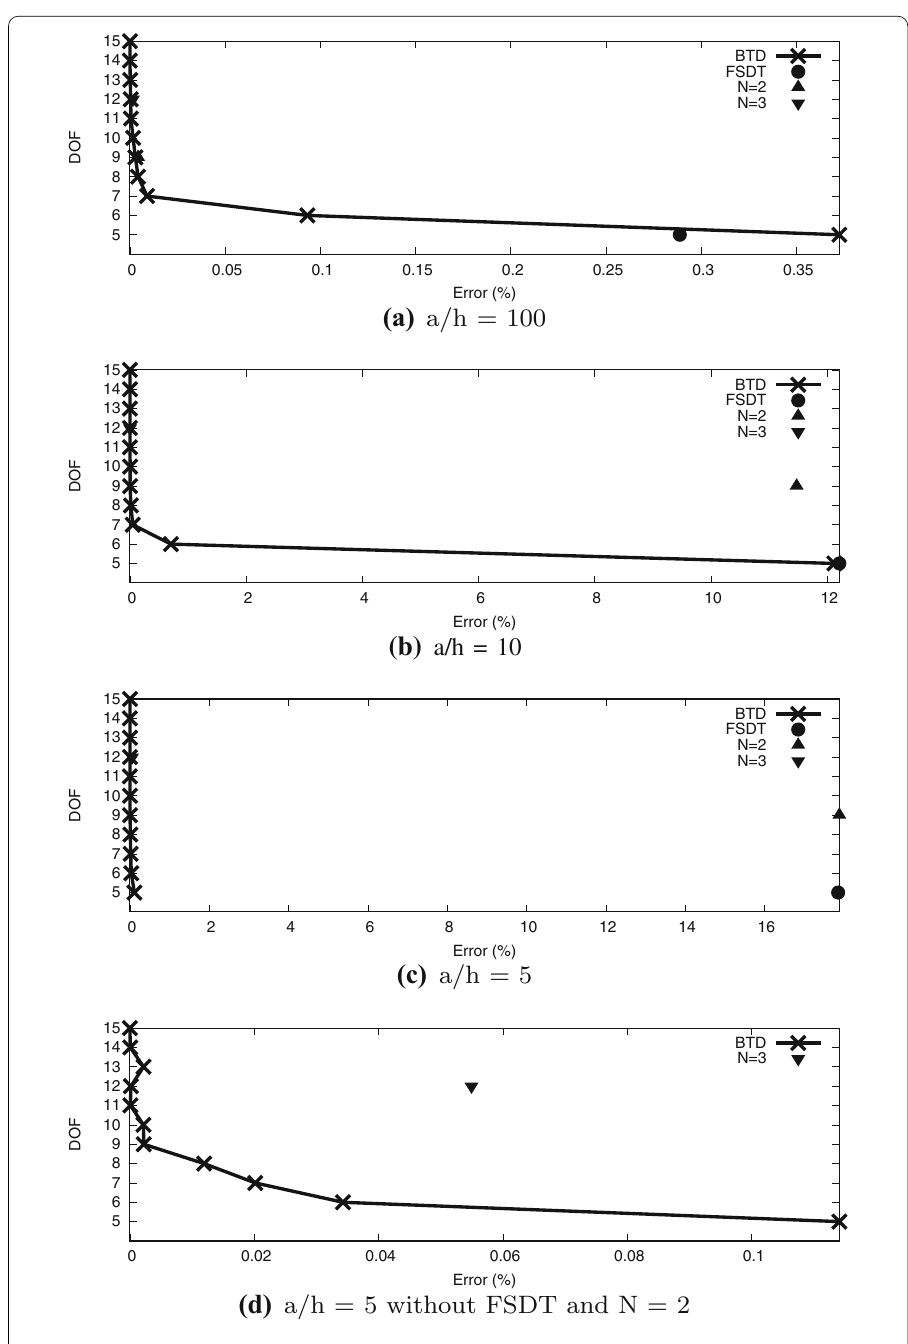
Fig. 4 BTD for 0/90/0, R/a =